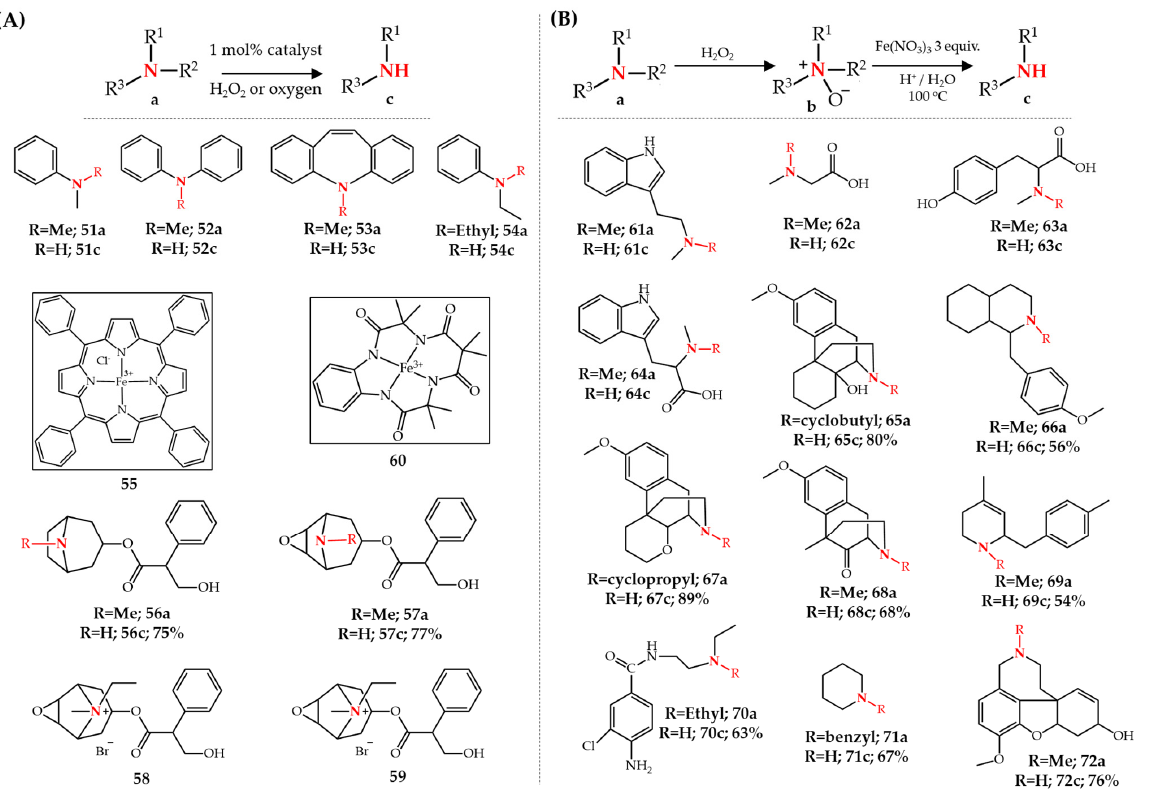
Figure 9. Fe ‐ catalyzed N ‐ dealkylation of tertiary amines ( A ) without and ( B ) with N ‐ oxide for ‐